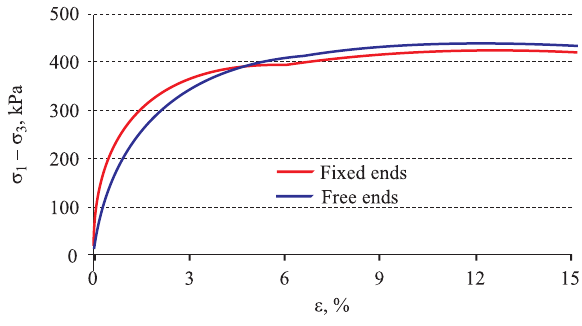
Fig. 3. Stress-strain graph of loose sand, when